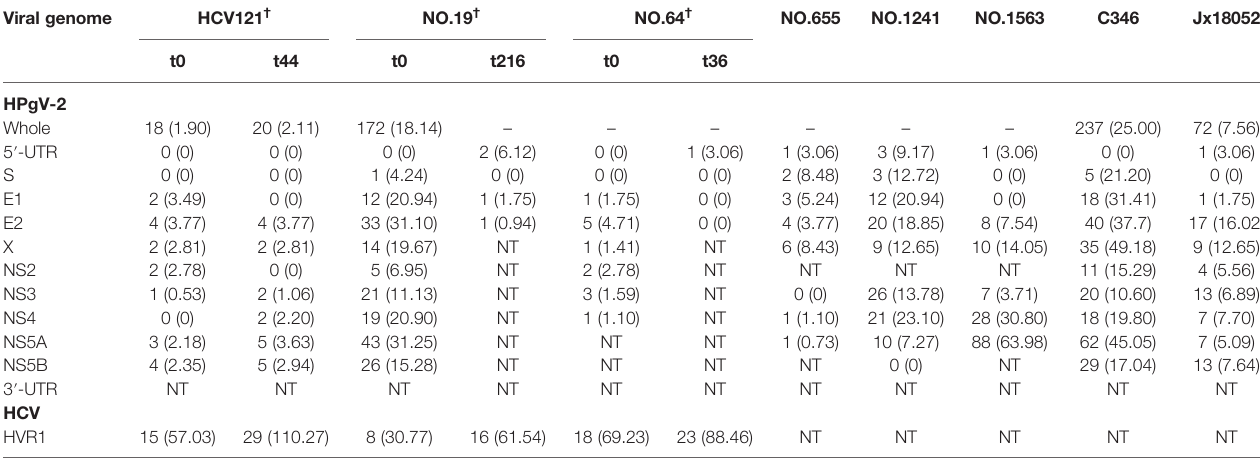
TABLE 1 | Distribution of intrahost single nucleotide variations (#iSNVs/kb) in the genome of HPgV-2 and HCV HVR1. Viral